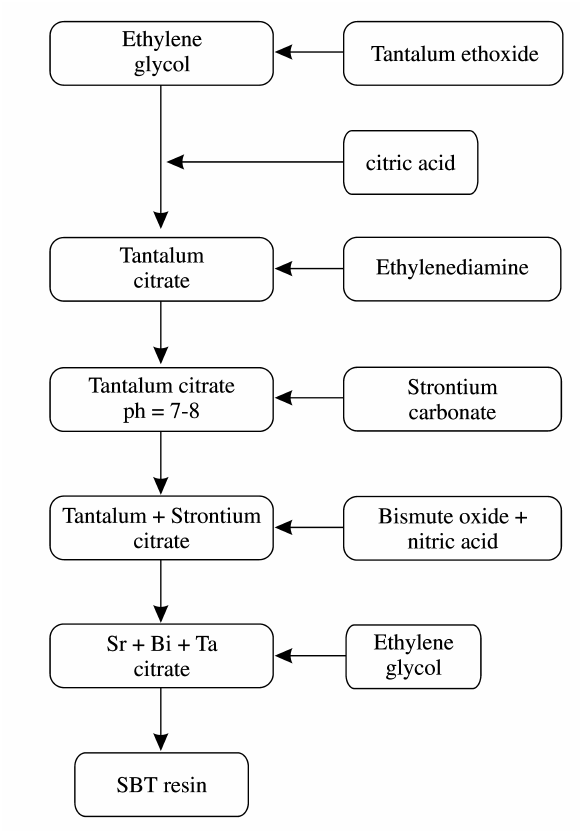
Figure 2. Flowchart for preparation of SBT resin.